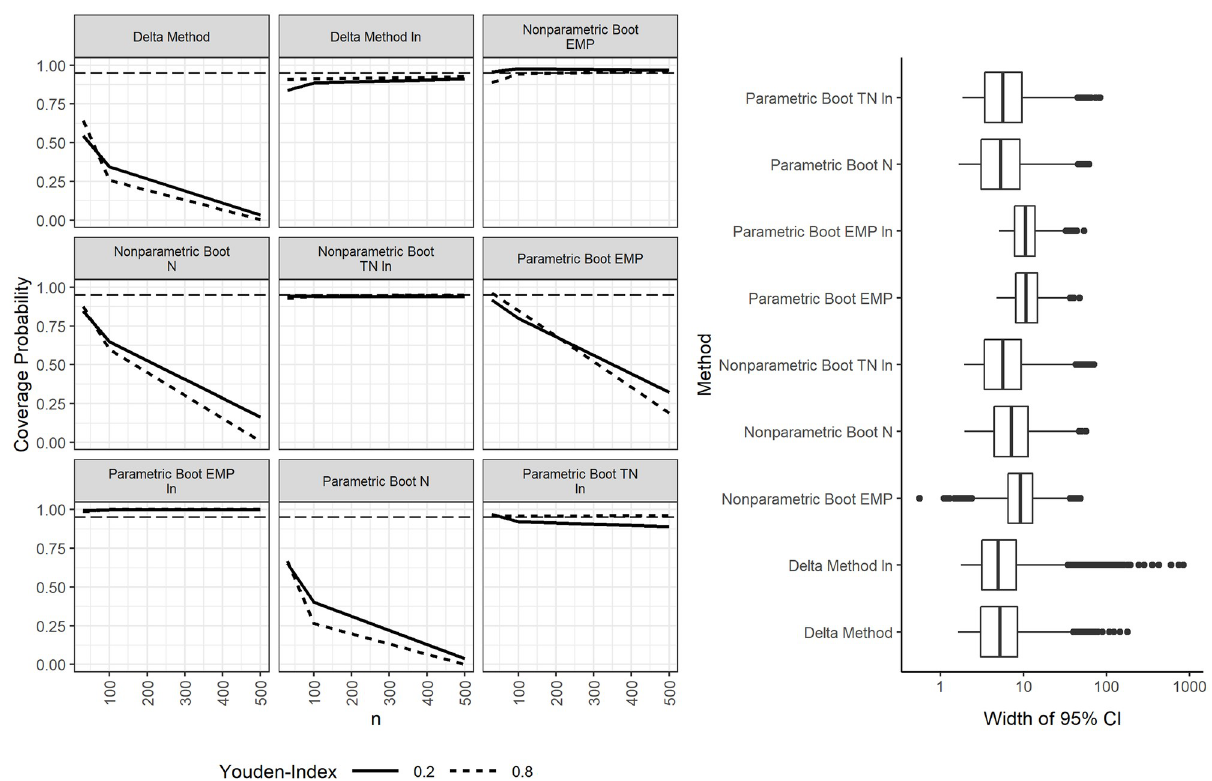
Fig 2. Coverage probabilities and widths of 95% confidence intervals for the optimal cutpoints on lognormally distributed data.